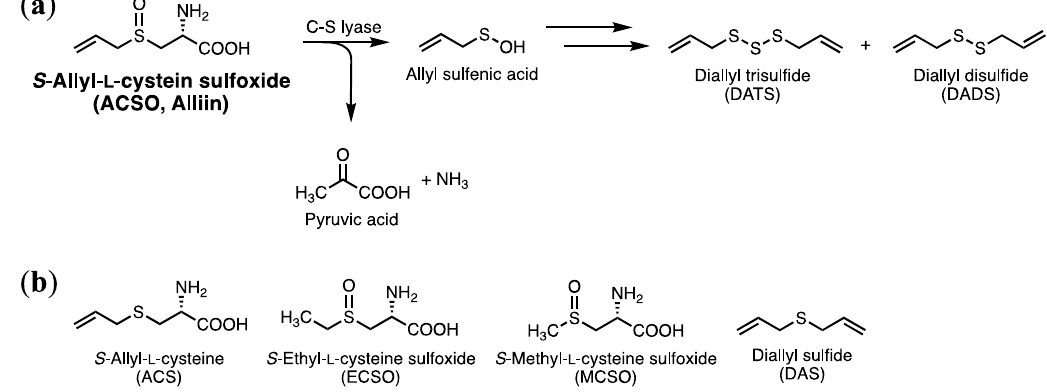
Figure 1. Production of garlic odor molecules from S -allyl- l -cysteine sulfoxide (ACSO) ( a ) and its related compounds tested in this study ( b ).